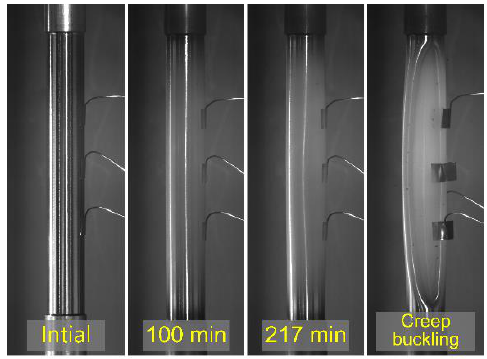
◦ C). Metals 2019 , 9 , x FOR PEER REVIEW